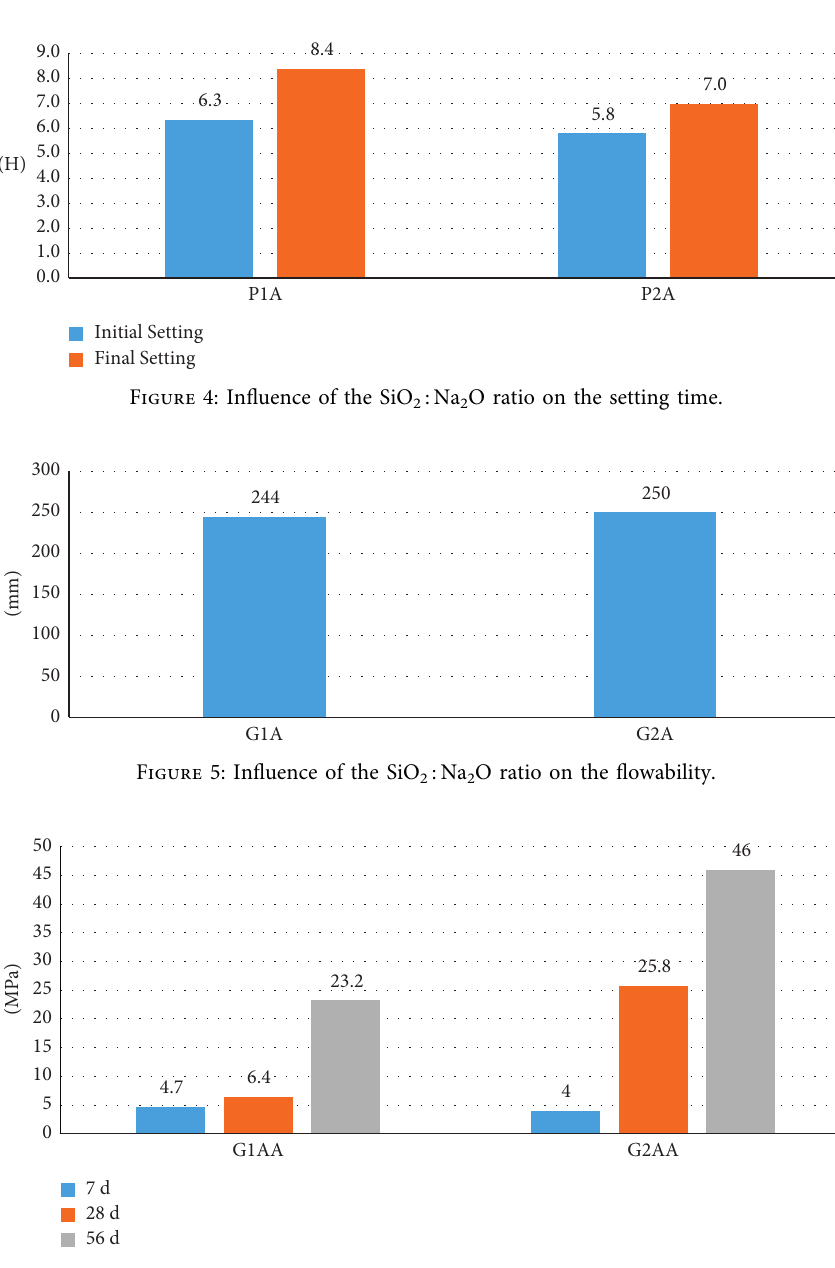
Figure 3: Influence of the change in concentration of sodium silicate on the 28-day compressive